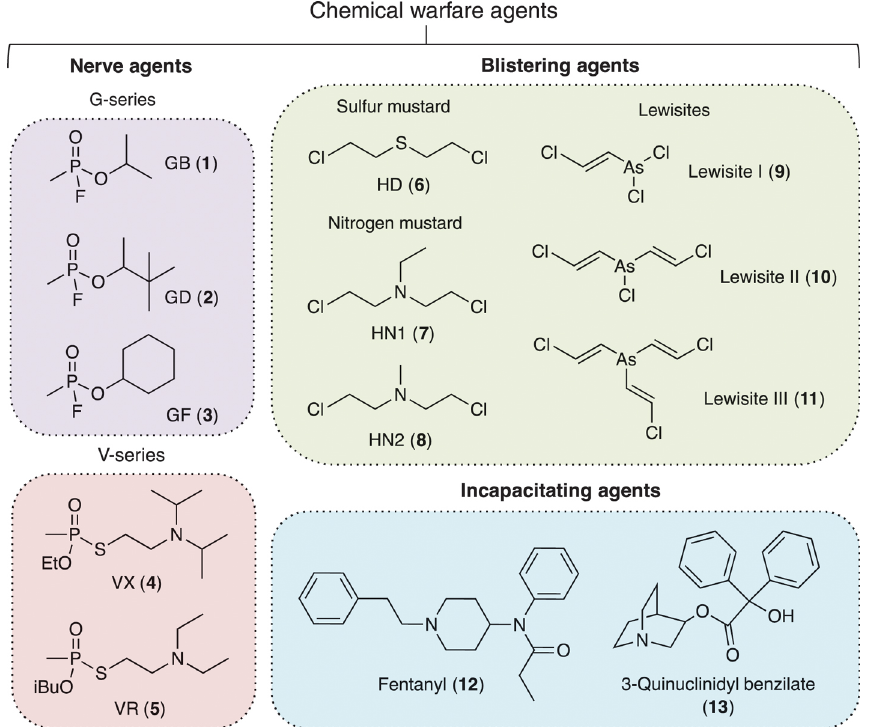
Figure 1: List of chemical warfare agent classes discussed in this review and their structures. Detection of CWAs in their intact form has relied on technologies that effectively trap the analyte (e.g. in a fiber) and subsequently analyze it by various analytical means [e.g. a field deployable gas chromatography-mass spectrometry (GC-MS) unit] (Hook et al., 2002; Smith et al. 2004; 2005). However, there exist instances where first responders to the scene of a presumed agent attack may not find it in its intact but degraded form. In such cases, it is necessary to indirectly detect the agent by a systematic analysis of the found by-products. For instance, when dealing with nerve agents, detection and correct identification of the phosphonic acids produced from their full hydrolysis is important for chemical forensics reasons (Mayer et al. 2012). Along these lines, proficiency tests (PTs) provided by the OCPW are aimed to recreate real case scenarios involving the employment of CWAs. During these examinations, degradation products that represent direct markers of these toxic chemicals are spiked into various matrices (water and soil samples) at concentrations normally lying within the 1 – 10 ppm range. These concentrations are chosen to recreate the levels at which these species may be found in real-case scenarios. As an example of the impact of the degradation process on these toxic substances consider the nerve agent GD ( 2 ) that degrades initially to its half ester pinacolyl methylphosphonic acid ( 14 ) that in turn undergoes a second hydrolytic step to provide methylphosphonic acid (MPA, 15 ) and pinacolyl alcohol (PA, 16 )